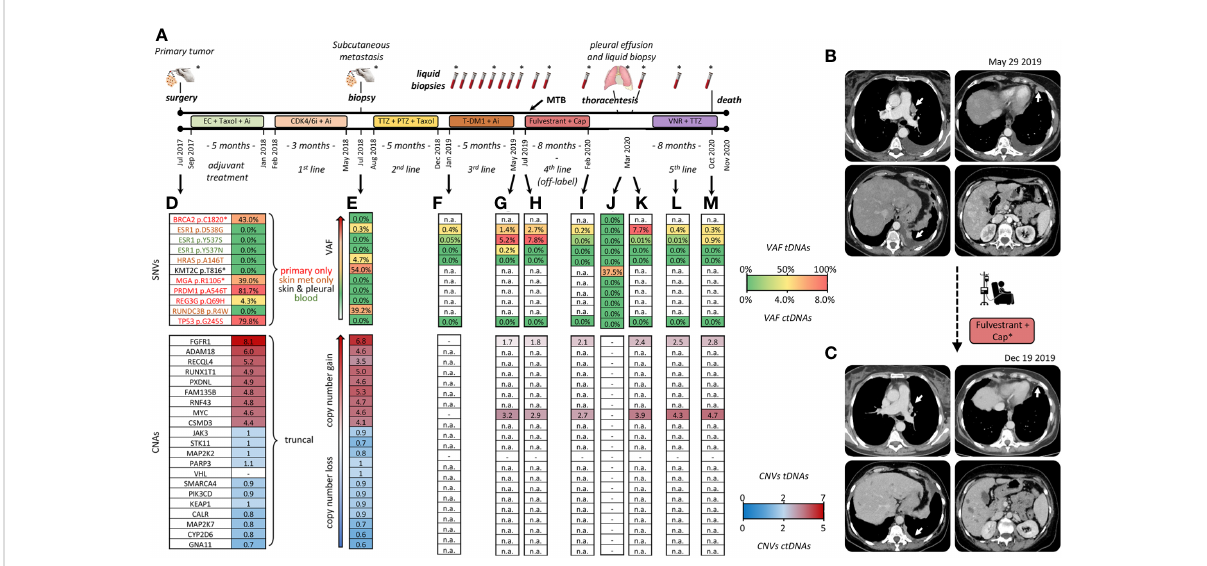
FIGURE 1 Clinical timeline and tumor pro fi ling. (A) Treatment history: adjuvant chemotherapy with Epirubicine plus Cyclofosphamide (EC: 90/600 mg/mq, q14), followed by Taxol (175 mg/mq, q14) plus Peg fi lgrastim, and Aromatase Inhibitor (Ai: Letrozole 2.5 mg/day). First line therapy with Palbociclib (CDK/6i:125 mg/die for 21 days, every 28 days) plus Aromatase Inhibitor (Ai: Letrozole 2.5 mg/day). Surgical removal of a thoracic skin metastasis. Second line with Trastuzumab (TTZ: 8 mg dose loading ! 6 mg) plus Pertuzumab (PTZ: 840 mg dose loading ! 420 mg) and weekly Taxol. Third line with T-DM1 (3.6 mg/kg, every 21 days) and Letrozole (2.5 mg/day), beginning of LB monitoring. Fourth line, off-label Fulvestrant (500 mg day 1, 15, 28, then every 28 days) in association with Capecitabine (Cap: 2000 mg/m 2 daily discontinued after a single cycle). Fifth line with Vinorelbine (VNR: 25 mg/mq at day 1 and 8) plus Trastuzumab (8 mg/kg -> 6 mg/kg) every 21 days. Asterisks: tissue and blood samples tested by both NGS and dPCR. All the other samples: testing by dPCR only. (B, C) CT scans before and following treatment with Fulvestrant; dates of clinical imaging are noted. Major sites of response to Fulvestrant are indicated by white arrows. Cap*, Capecitabine (D – M) Key time points at which tumor tissue/cells and blood drawings were obtained. Single nucleotide variants (SNV) are color-coded by tissue of origin in (D) . Palettes rank alterations by variant allele frequency (different %VAFs) and copy numbers (CNA). Copy numbers are expressed per diploid genome: copy number-neutral n=2. tDNA, tumor DNA; ctDNA, circulating tumor DNA. (-) undetectable. n.a., not assessed because SNV/ CNA was not included in the LB-grade NGS